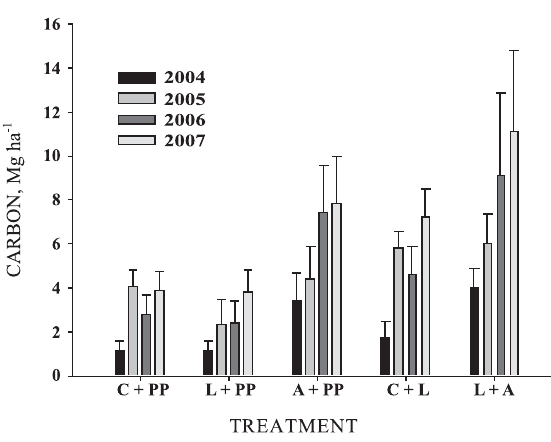
Figure 1. Carbon stocks in leguminous mixtures under different treatments for four years. C+PP: clitoria + pigeon pea; L+PP: leucaena + pigeon pea; A+PP: acacia + pigeon pea; C+L: clitoria + leucaena; L+A: leucaena +